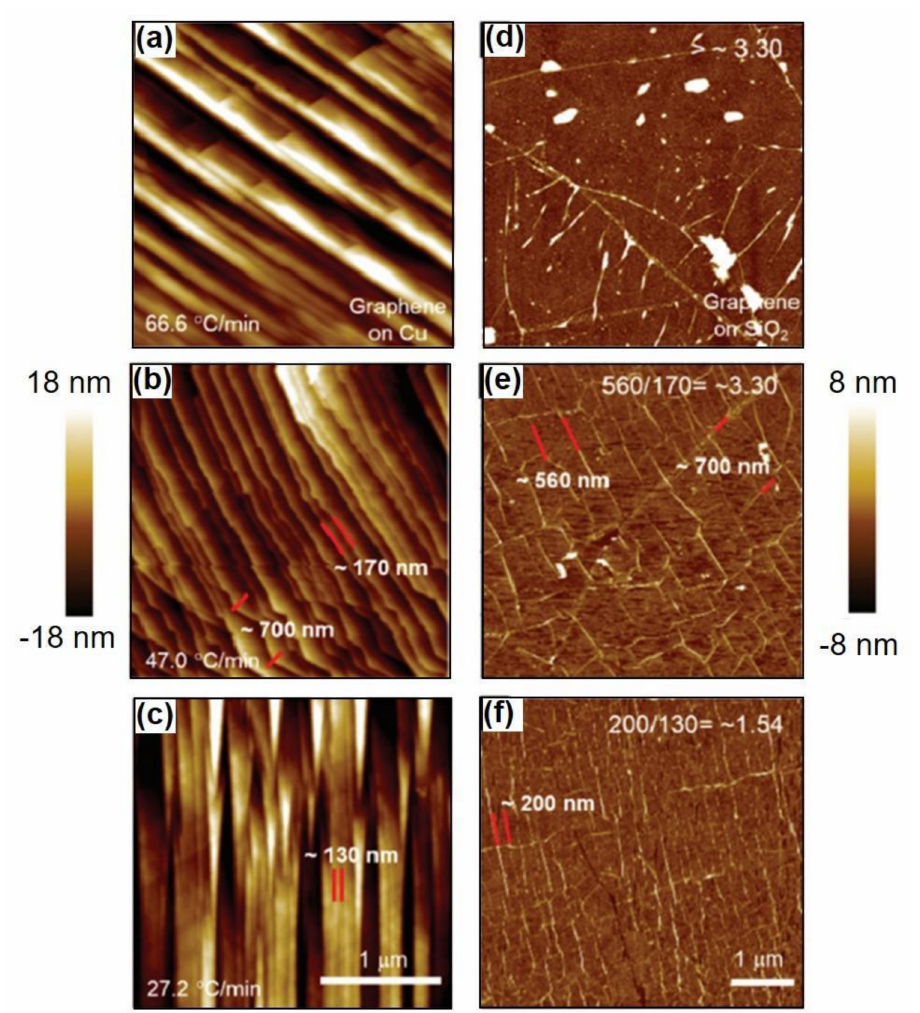
Figure 14. ( a – c ) Cu surface features were recorded by AFM studies subsequent to CVD-MG growth with varying rates of cooling (66.6, 47.0 and 27.2 ◦ C min − 1 ). ( d – f ) AFM images of CVD-MG subse- quent to mounting on the SiO 2 /Si substrates. Characteristic distances between Cu nanoscale-terraces and RP-to-RP distances on SiO 2 /Si substrates were identified by the red bar. The values of expansion ratio obtained by dividing the RP-to-RP interval value on SiO 2 /Si substrates by the distances between Cu nanoscale-terraces were indicated in white. Reprinted with permission from ref.